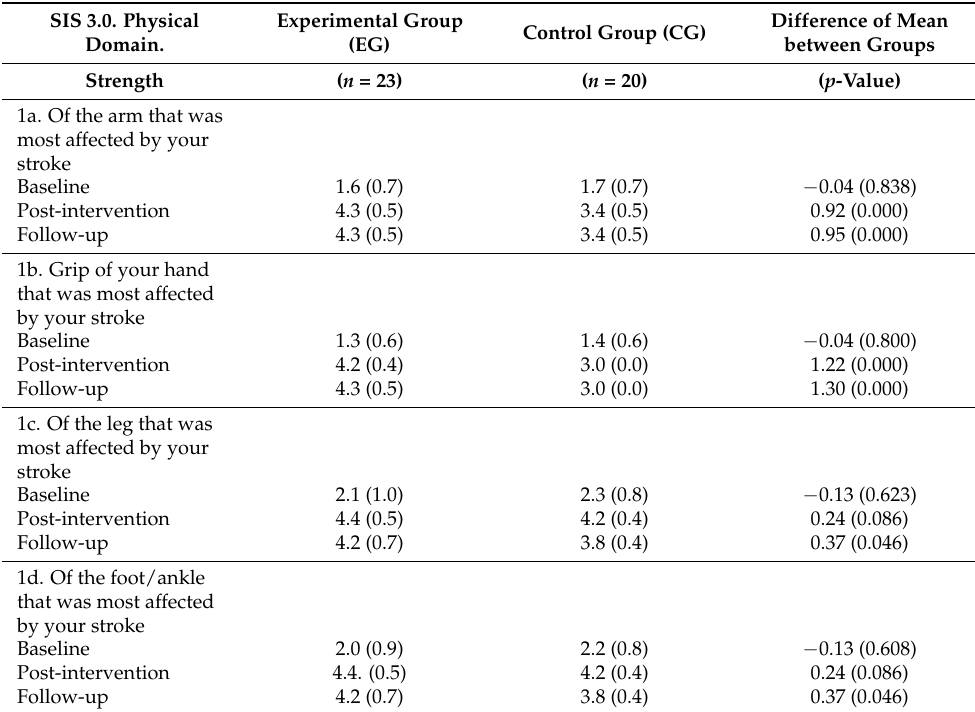
Table 3. Difference in means of physical domain (strength) according to intervention group as measured by SIS 3.0 ( n =